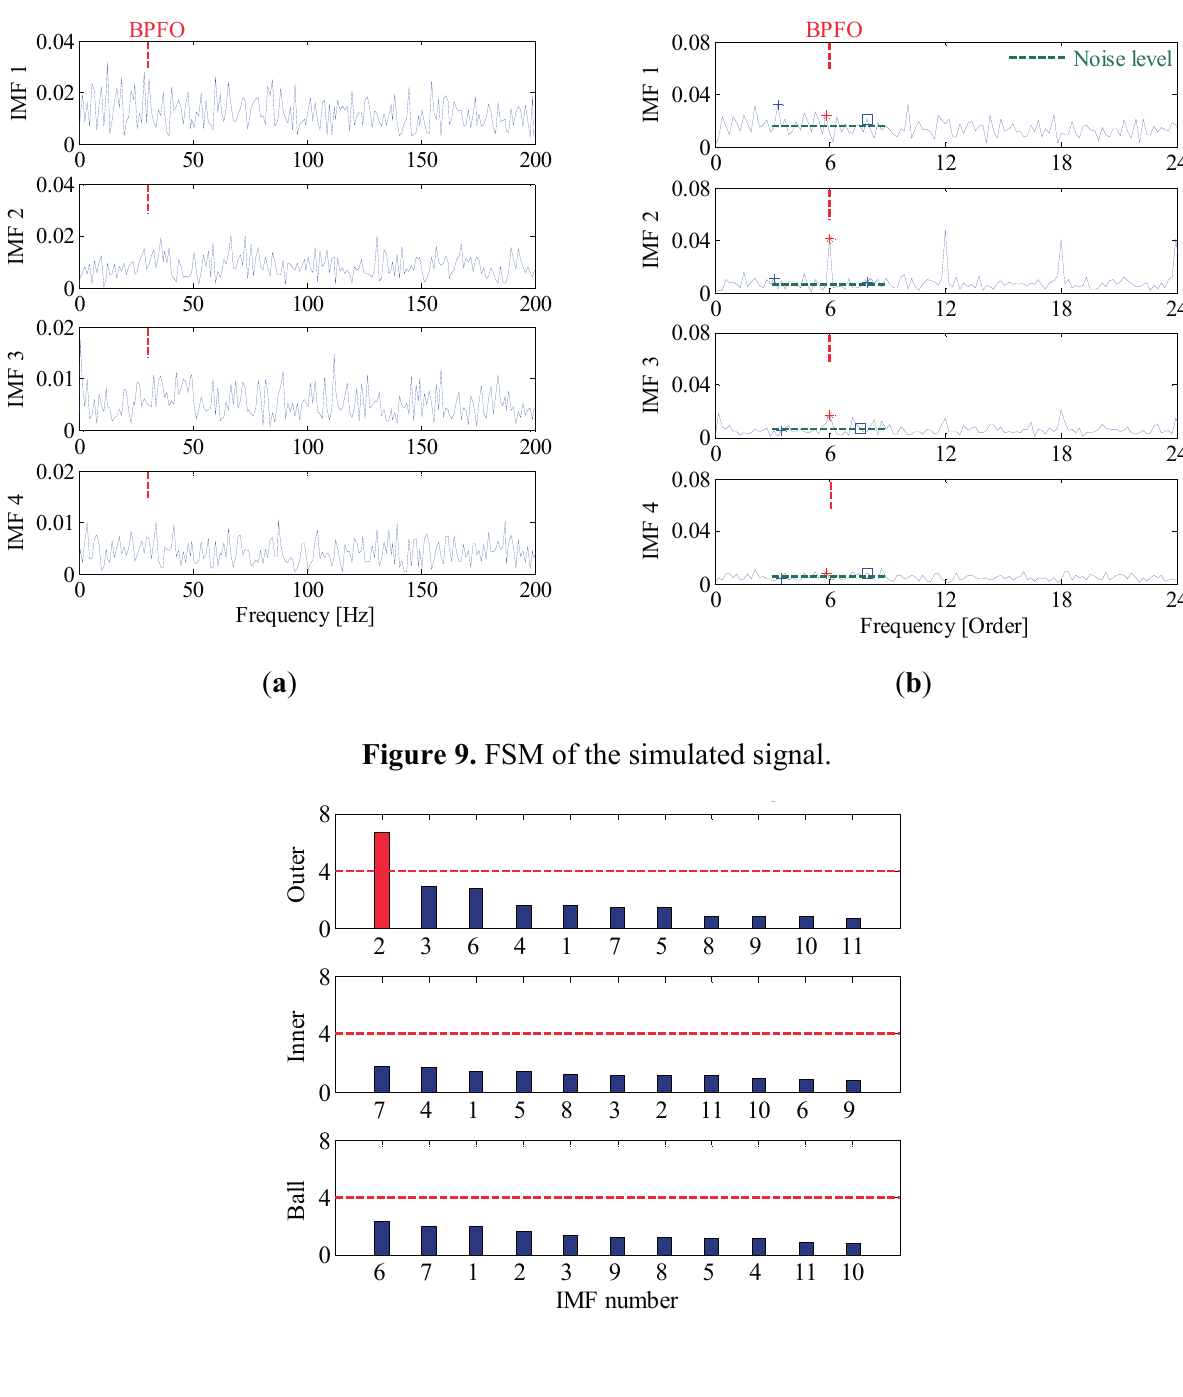
Figure 8. Comparison between ( a ) envelope spectrum and ( b ) envelope order spectrum for IMFs.